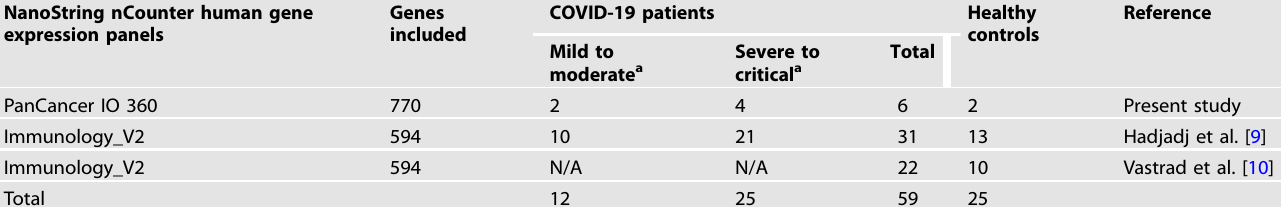
Table 1. Comparative Ras genes expression in three independent dataset of COVID-19 patients analyzed by NanoString nCounter technology. NanoString nCounter human gene expression panels